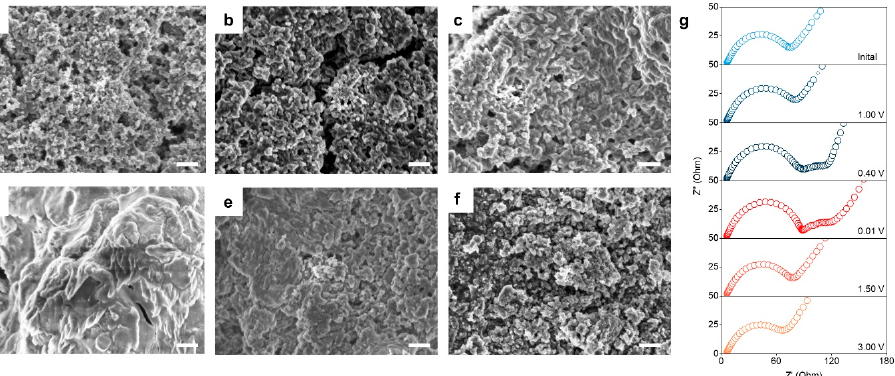
Figure 4. ( a – f ) The microstructural changes of TP-Ni electrodes in di ff erent electrochemical states. Scale bar: 1 µm. ( g ) Nyquist plots of TP-Ni electrodes in di ff erent electrochemical states during the fi rst discharge/charge cycle.